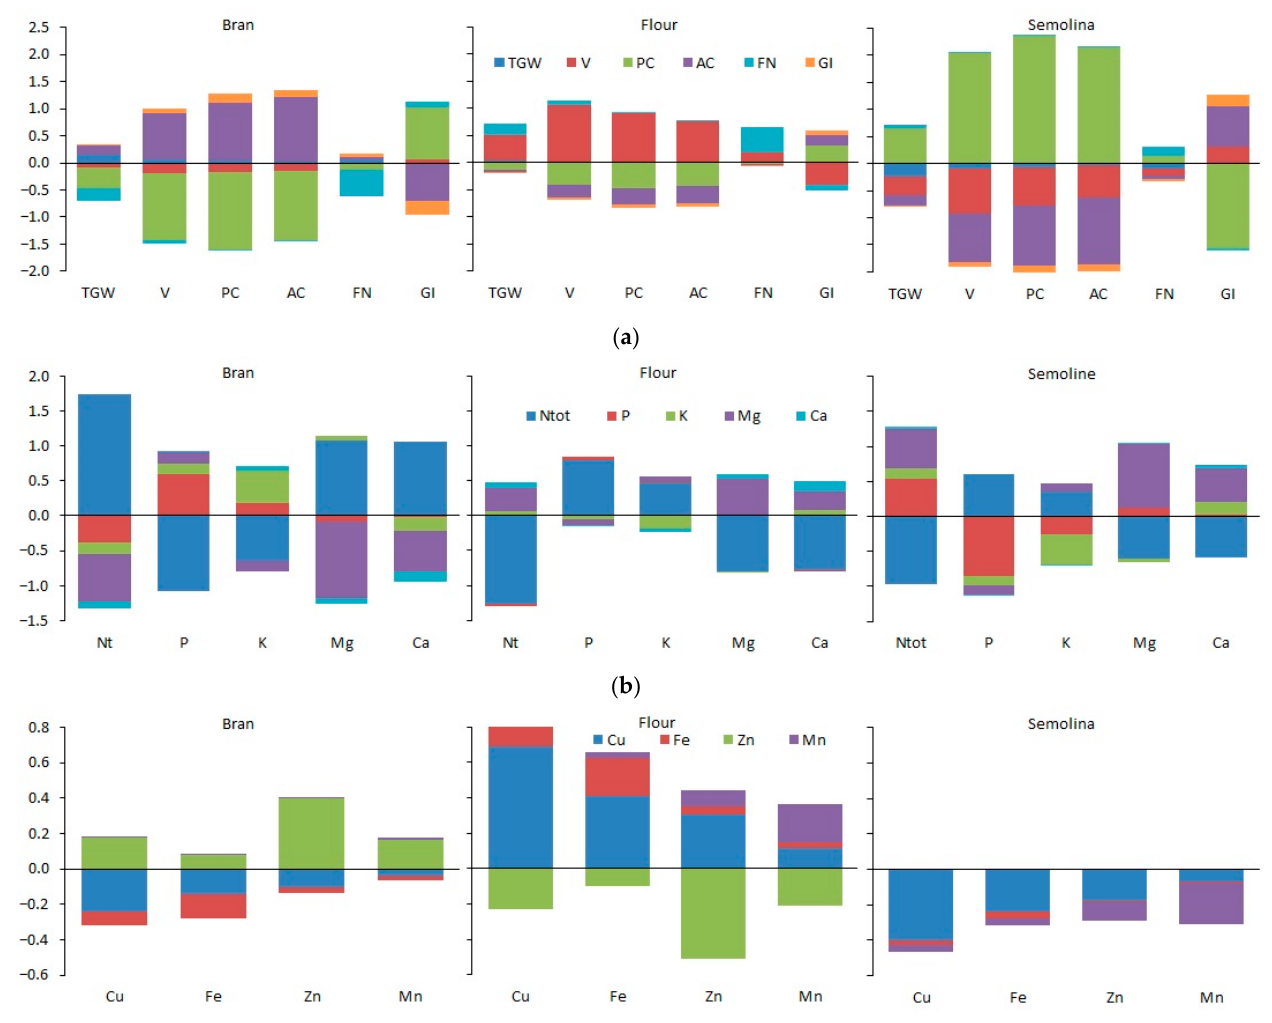
Figure 3. Decomposition of correlation coefficients into direct and indirect effects of: ( a ) grain quality parameters and milling yield components, ( b ) macronutrients and milling yield components, and ( c ) micronutrients and milling yield components (the direct effect of a given independent variable is marked in color and denoted on the X -axis). Refer to Table 1 for the key and to Figure 1 for the diagram of direct and indirect effects (e.g., bran in Figure 3a: TGW values marked in blue on the X -axis indicate a direct effect, whereas the parameters marked in other colors indicate indirect effects).